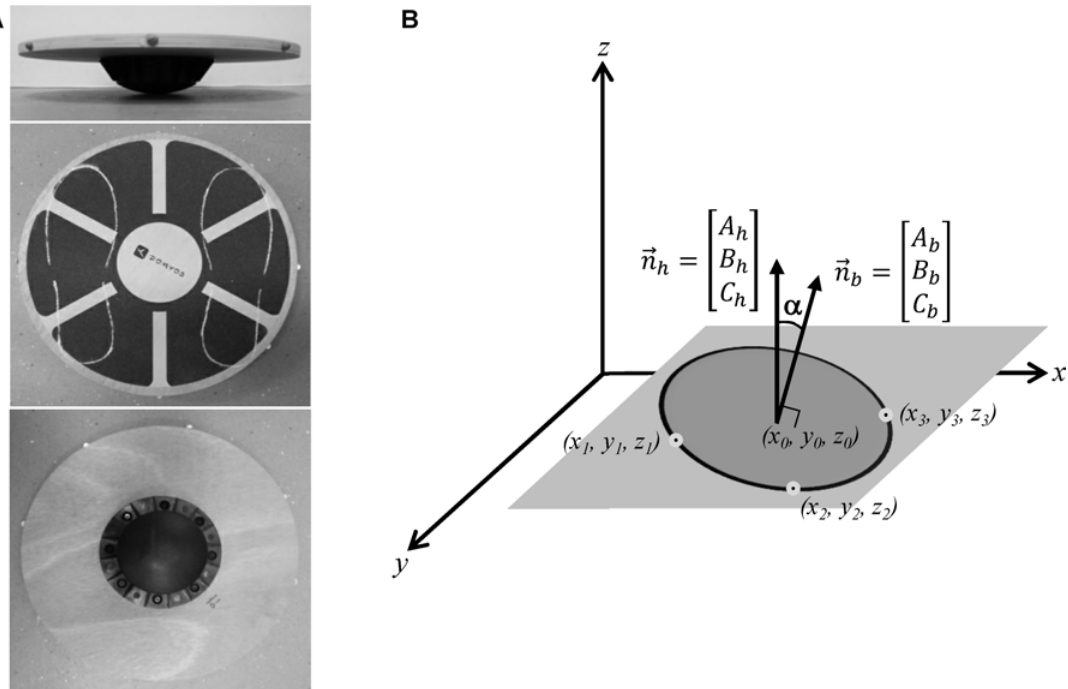
Fig 1. Experimental set up. Balance board (A) used in the experimental procedure and the frame of reference (B) to compute the normal vector for the horizontal ( n ! h ) and the board ( n ! b ) plane. The angle α indicates the discrepancy between the two planes. The origin of the reference system is determined by the calibration of the motion capture system. See text for further details.